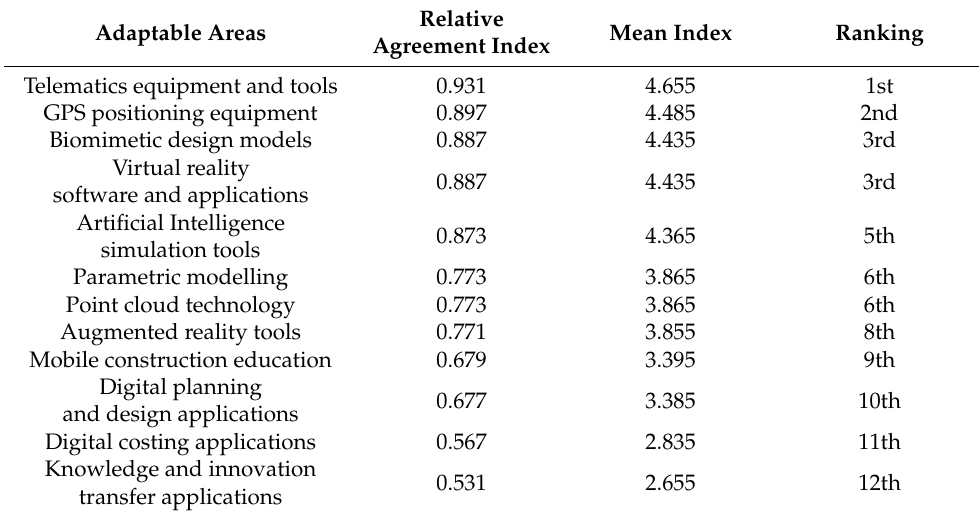
Table 2. Adaptable Construction 4.0 (C4.0) in Infrastructural Innovation in Design, Planning, Con- struction and